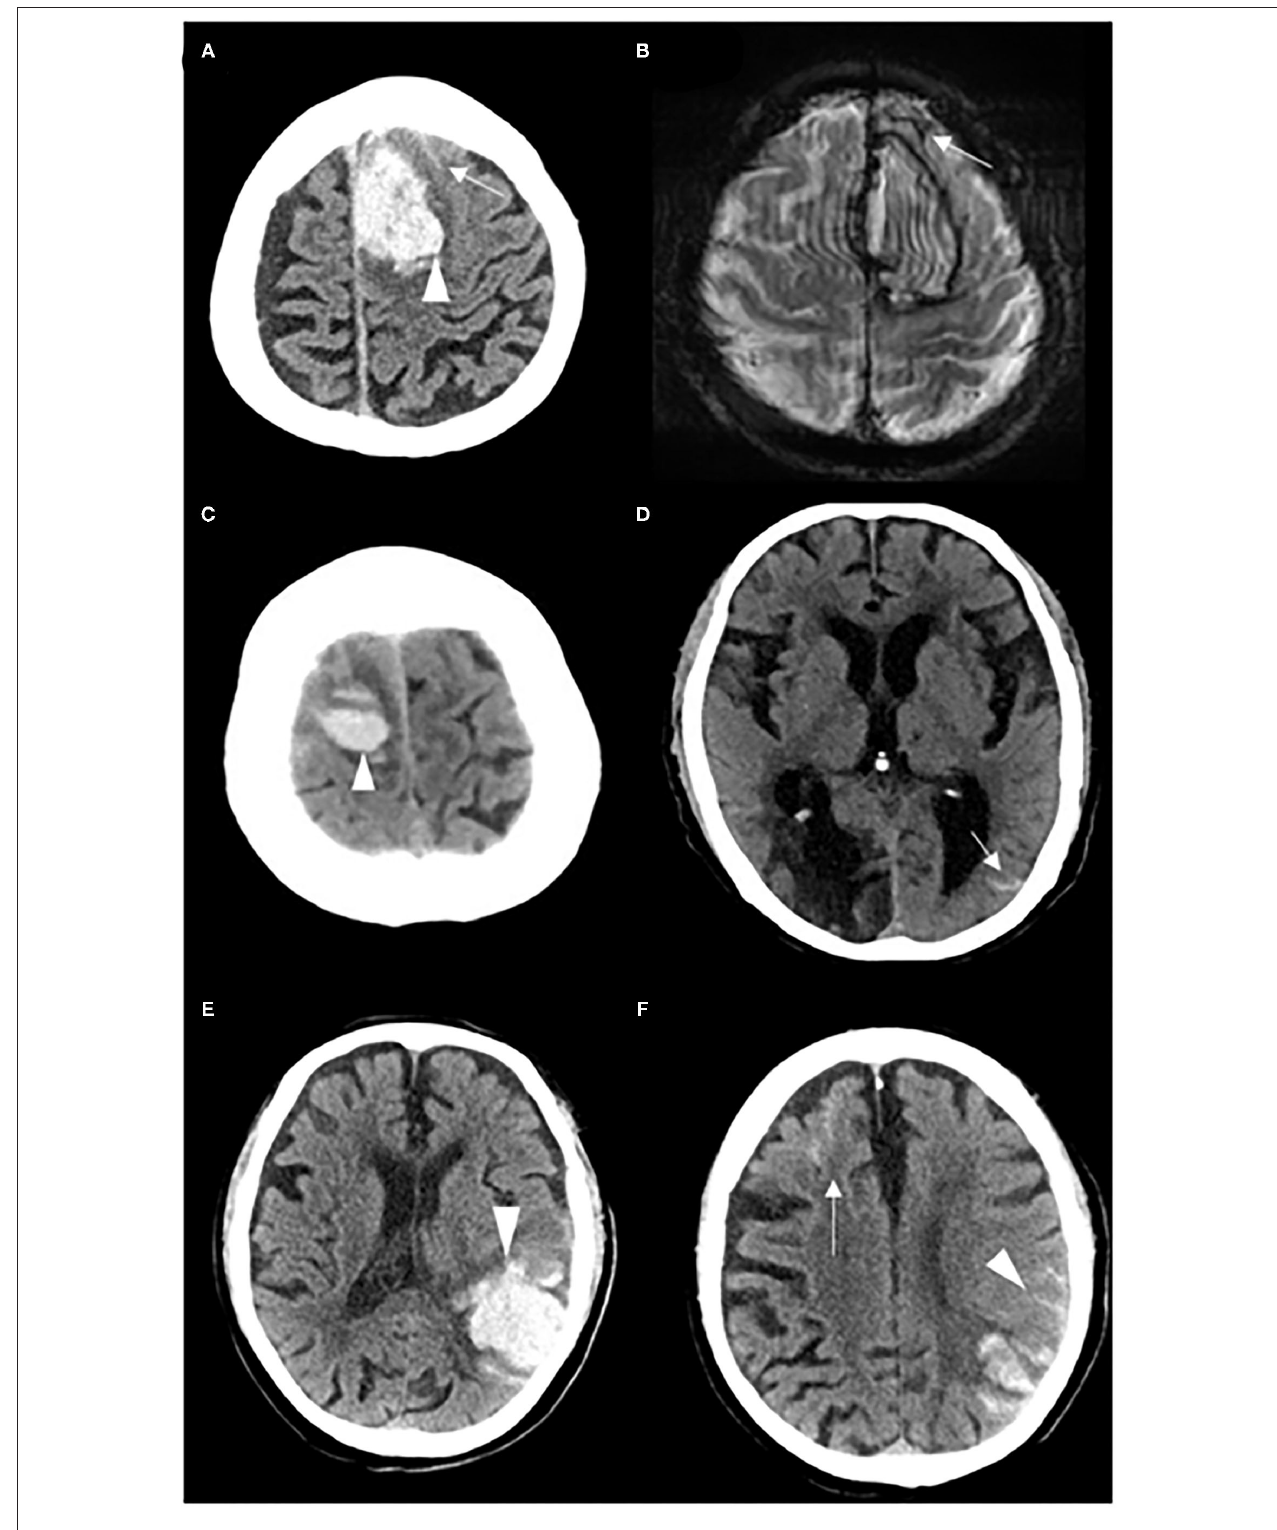
FIGURE 1 | Representative examples of adjacent cSAH and remote cSAH. (A) A patient with adjacent cSAH: cSAH (white arrow) was observed within 1–2 sulci from the acute left frontal ICH (white head of arrow), and (B) cSS (white arrow) on the T2*-weighted gradient-recalled echo at 1 month after the index ICH. (C,D) A patient with remote cSAH: cSAH (white arrow) was detected on the left side, remote from the acute right frontal ICH (white head of arrow). (E,F) A patient with remote cSAH: cSAH (white arrow) was detected in the left frontal lobe, remote from the acute left temporal parietal ICH (white head of arrow), with adjacent cSAH (white head of